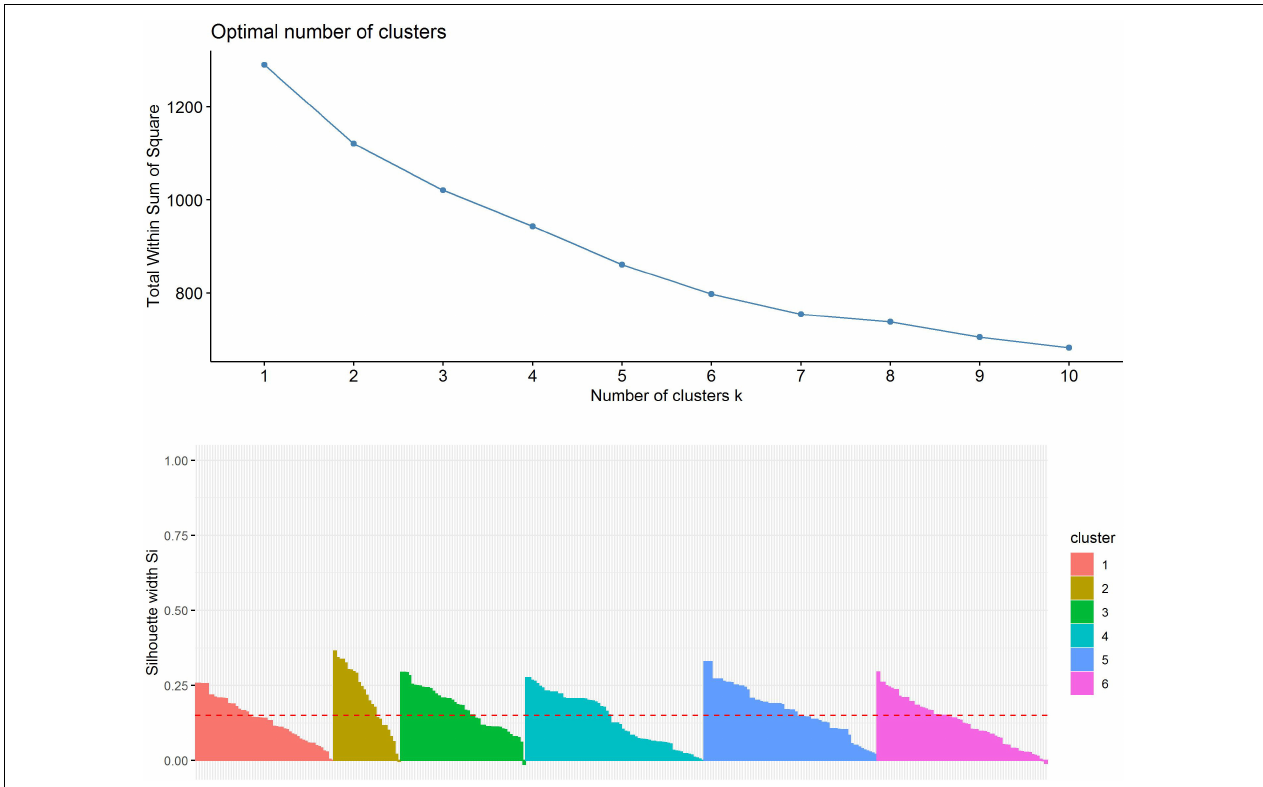
FIGURE 3 | Evaluation of optimal number of clusters by the “elbow” method using the total within Sum of Squares ( upper panel ). Evaluation of cluster integrity by calculation of Silhouette width of each cluster ( lower panel ).